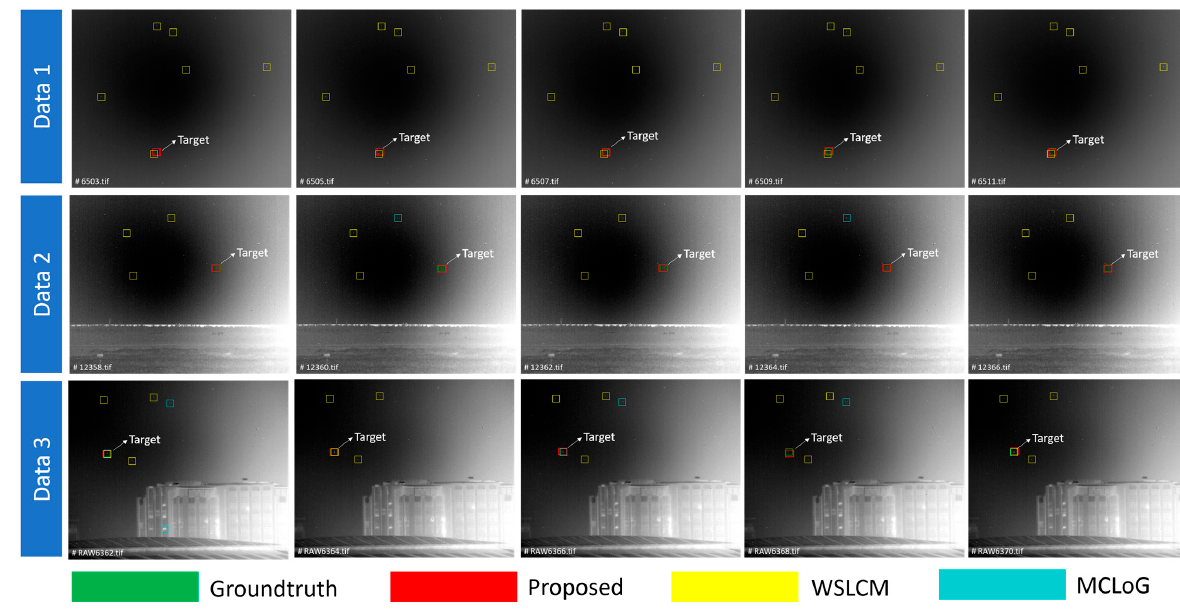
Figure 13. Detection results between our method and traditional single-frame-based methods in self-made datasets. The target has been marked by texts, and the other prediction boxes are false alarms. Experimental results show that the proposed method has the highest coincidence with the ground truth.